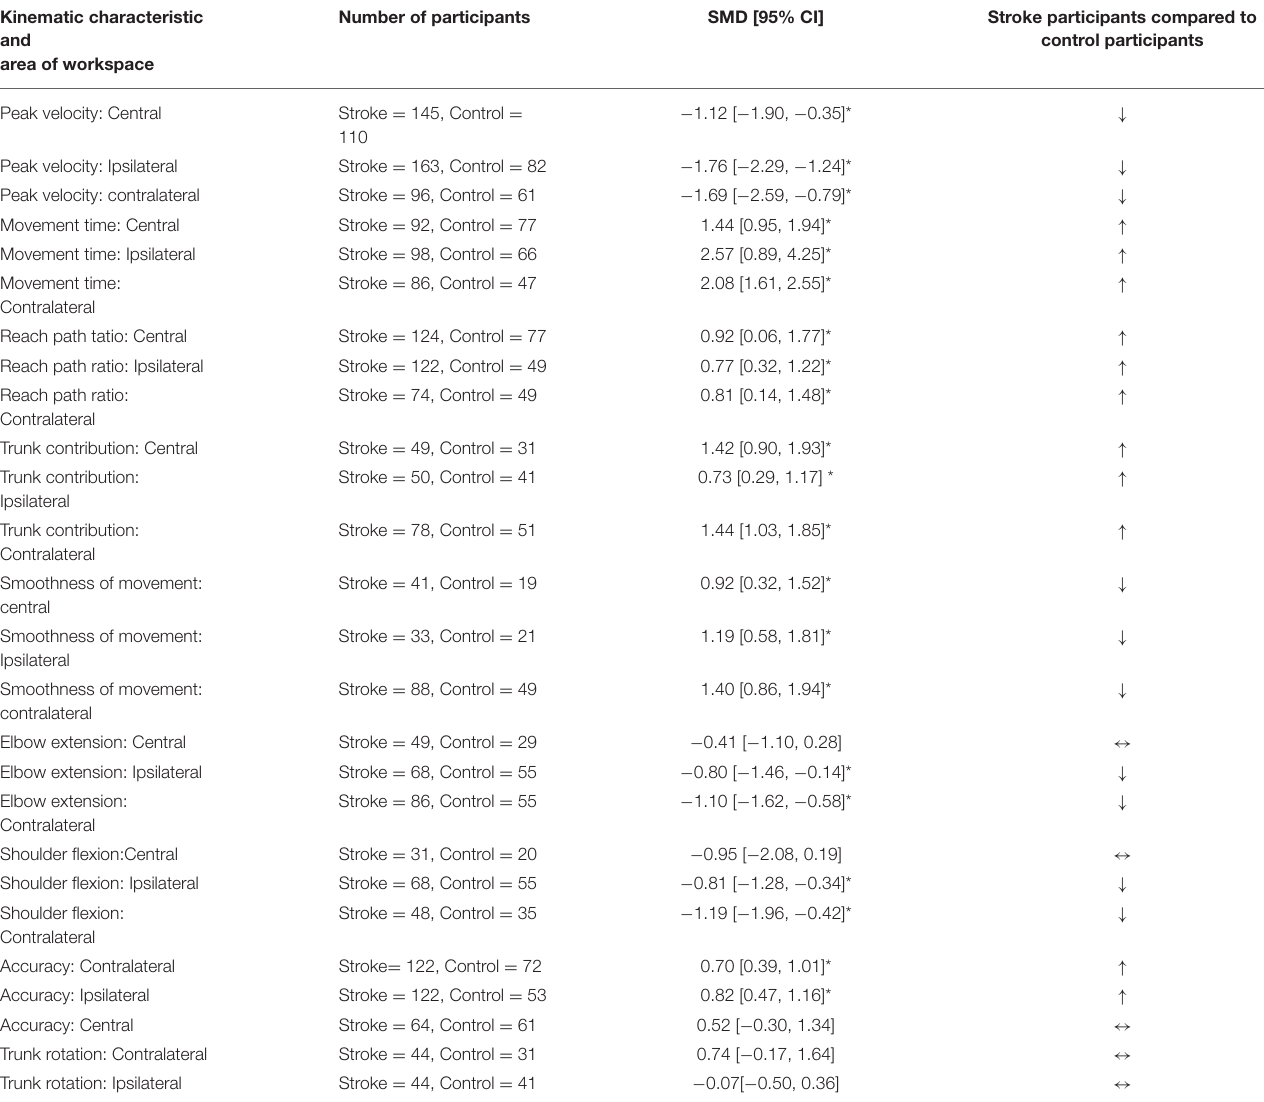
TABLE 7 | Summary of the meta-analyses of the kinematic characteristics of reach-to-target. Kinematic characteristic and area of